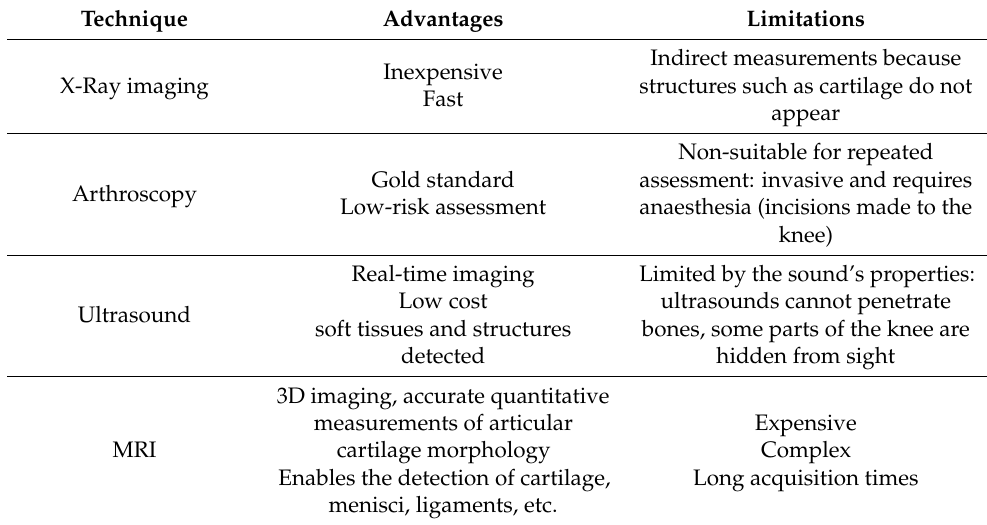
Table 1. Comparison of the currently used diagnostic techniques for knee inspection. Technique